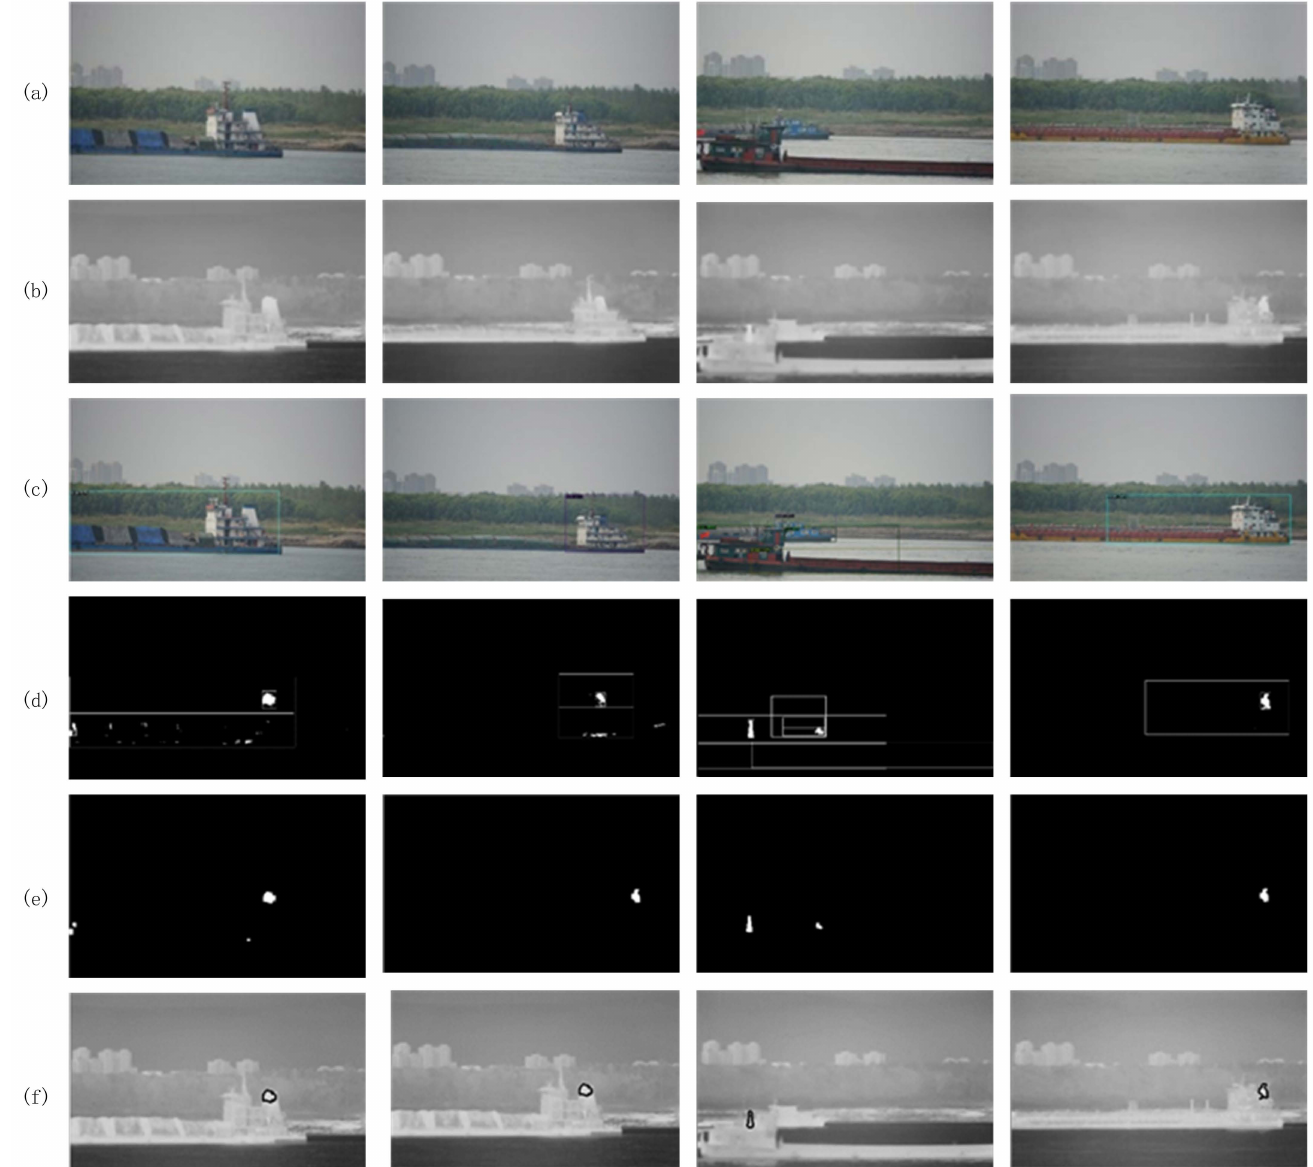
Figure 14. Chimney inspection. ( a ) Visible light input diagram. ( b ) Infrared camera input diagram. ( c ) First-level test results. ( d ) Optimization of detection range. ( e ) Secondary test results. ( f ) The results are displayed in the original